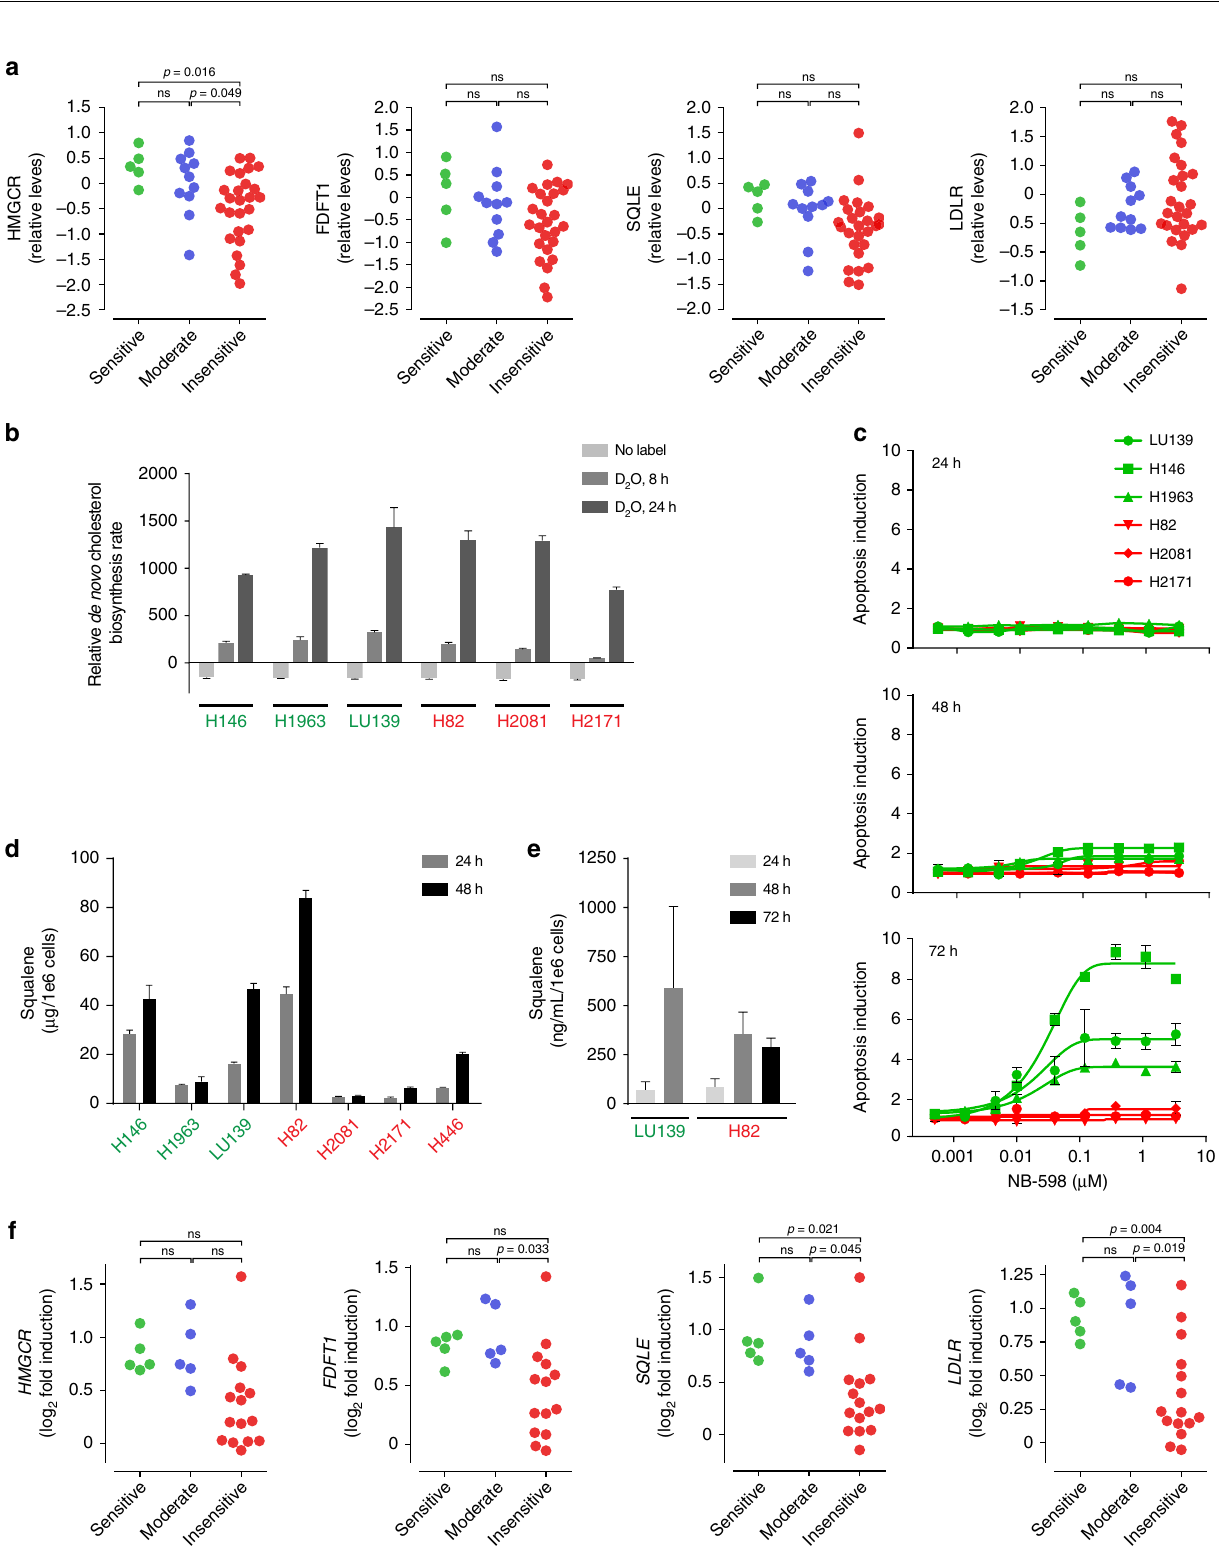
fl uvastatin and atorvastin inhibiting HMGCR 16 and lapaquistat inhibiting Δ 7 -sterol reductase 21,22 , did not show signi fi cant inhibiting squalene synthase 17 , did not display a similar sensitivity in the cell lines tested (Fig. 5h). Collectively, this data suggest that NB-598 sensitivity does not appear to represent a sensitivity pro fi le to NB-598 (Fig. 5h). Similarly, agents down- generic cholesterol pathway-level requirement and that accumu- stream of SQLE, such as Ro48 – 8071 inhibiting lanosterol lation of SQLE substrate, squalene, is critical for the observed synthase 18 , azalanstat inhibiting lanosterol C14-alpha demethy- growth inhibitory effects. lase 19 , SR31747 inhibiting 7,8-sterol isomerase 20 , and AY9944 NATURE COMMUNICATIONS| (2019) 10:96